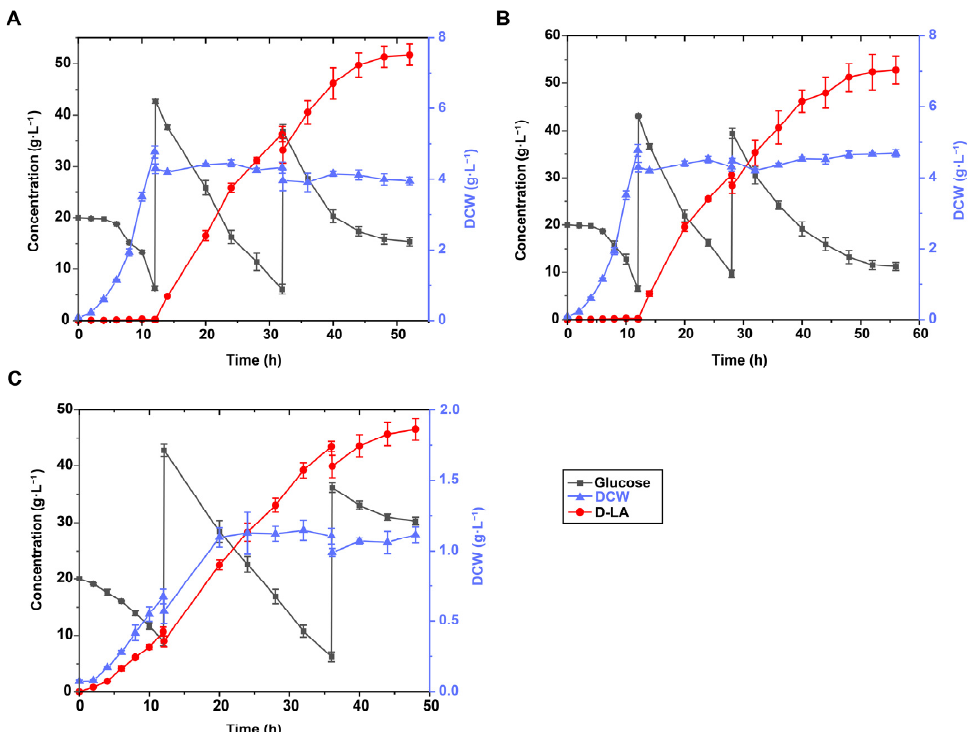
Figure 3. Effect of three different fermentation patterns on the synthesis of D-LA utilizing glucose by strain LBBE317. ( A ) Two-stage fermentation I (TPF1, growth stage with oxygen supply and high- speed agitation, switching to restricted oxygen supply and low low-speed stirring at transition to acid production stage). ( B ) Two-stage fermentation II (TPF2, same growth stage as TPFI, transition to microaerobic state with little aeration and low speed agitation). ( C ) Single-stage fermentation (SPF, low-speed stirring for full process oxygen limitation